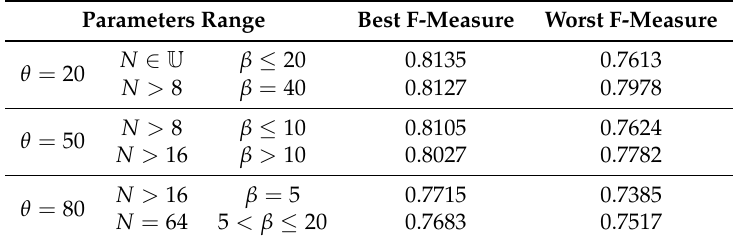
Table 5. Average F-Measure on the test videos with different parameters range for the motion map.